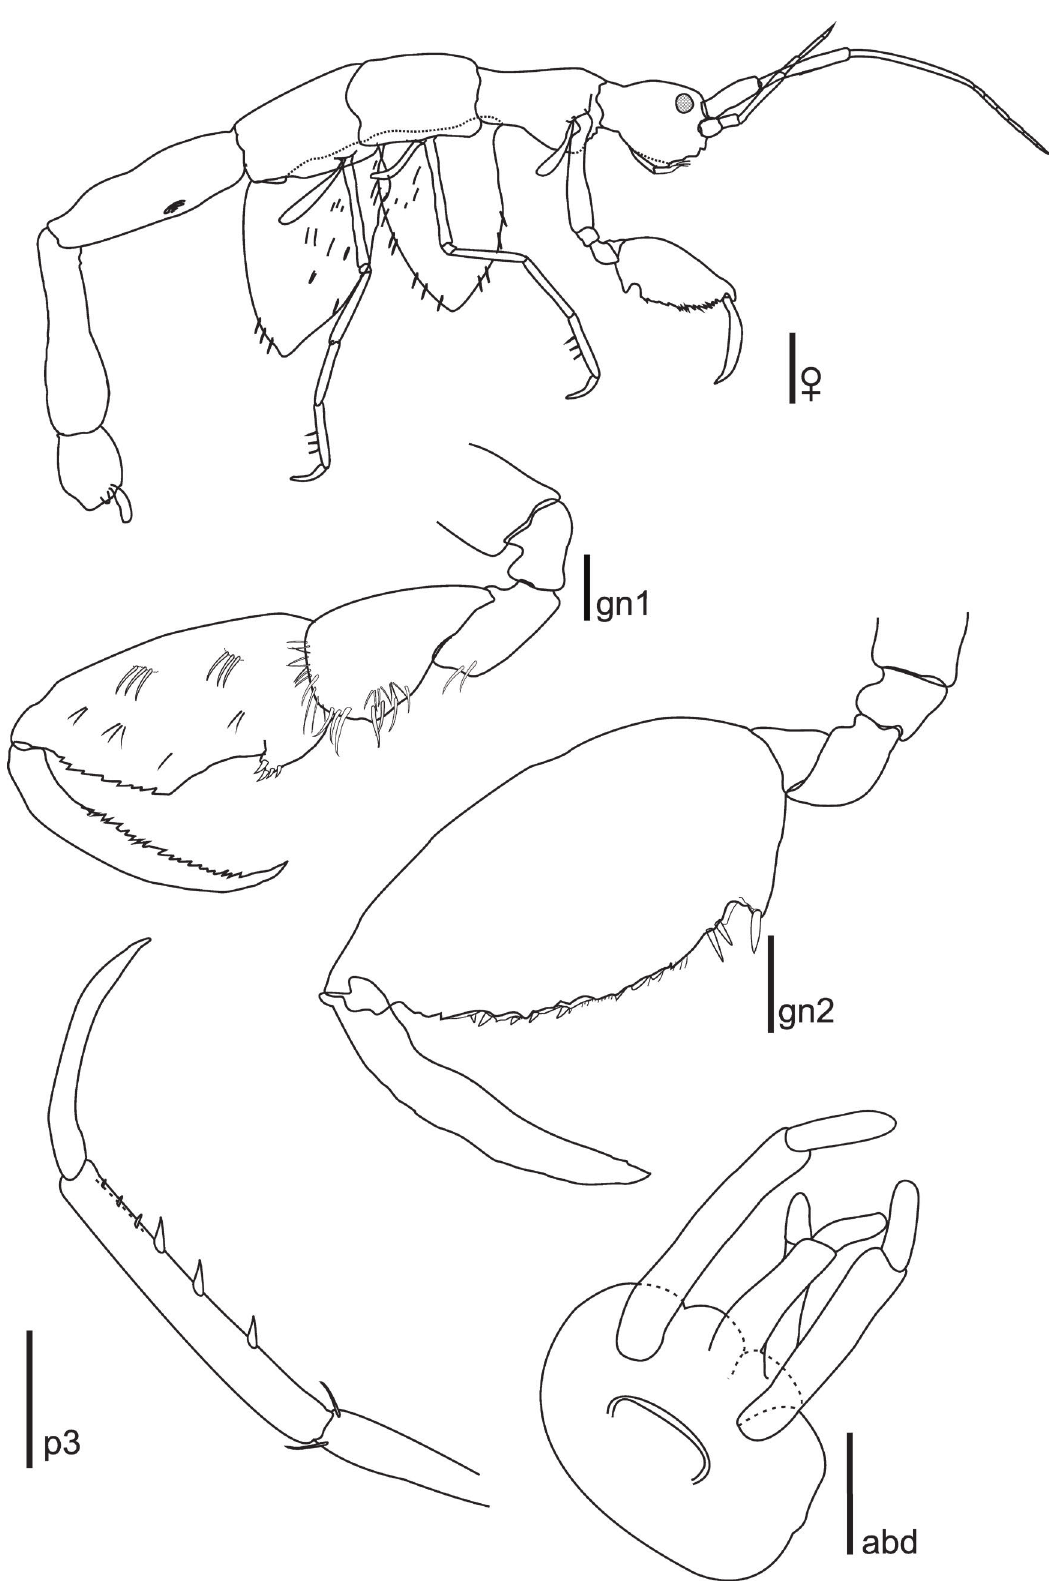
Fig. 5. Phtisica marina Slabber, 1769. Female, 7.9 mm, Angra dos Reis, RJ (CDZRJ 1012). Scale bars: habitus = 1.0 mm; gn1, gn2, p3, abd = 0.1